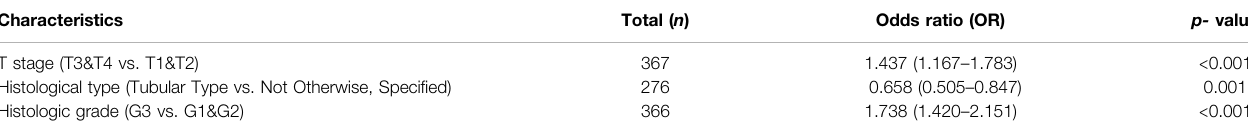
TABLE 2 | Univariate logistic regression assesses the relationships between GGT5 and clinical characteristics of gastric cancer patients. Characteristics Total ( n ) Odds ratio (OR) p- value T stage (T3&T4 vs. T1&T2) Histological type (Tubular Type vs. Not Otherwise, Speci fi